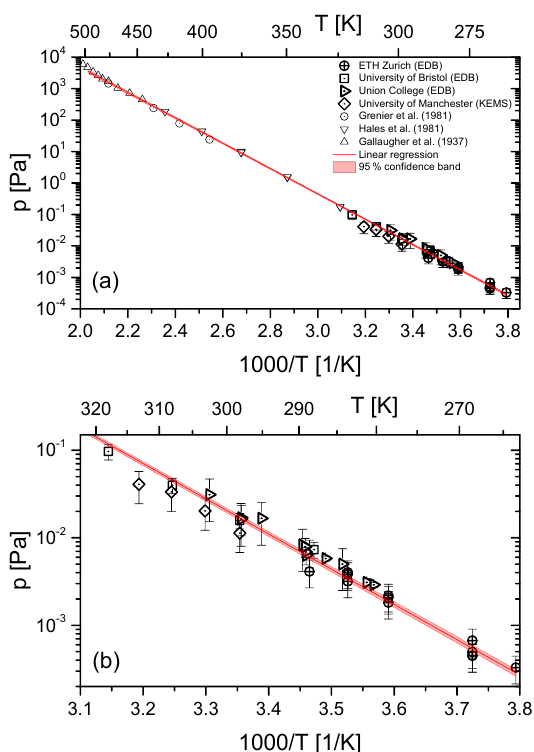
Figure 3. Saturation vapor pressures vs. temperature of tetraethy- lene glycol (PEG4). Bold open symbols: this work; open symbols: data reported in the literature. Red line: linear regression of all data below 495K. (a) Overview of all data, (b) cut-out showing the pres- sure range of the experimental data of this study.